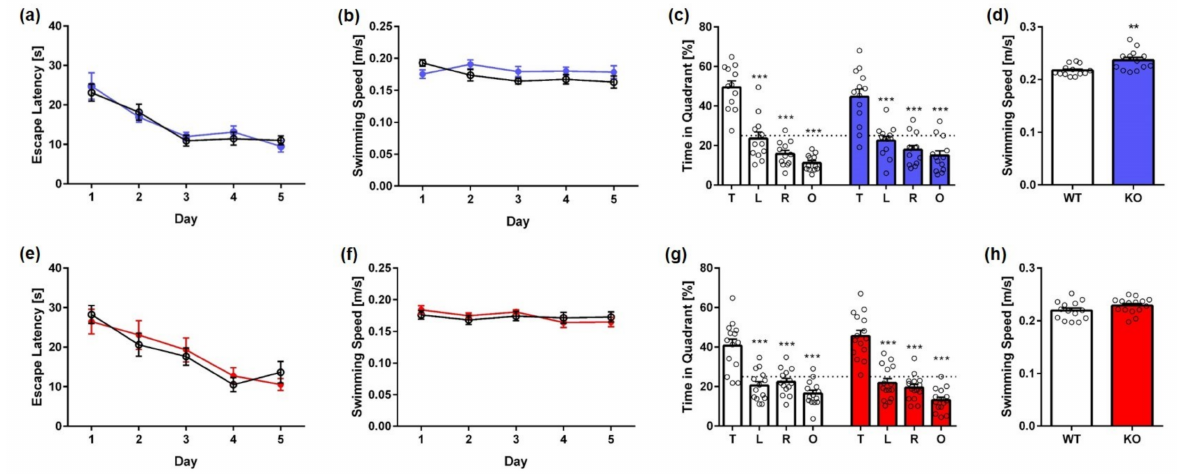
Figure 3. Spatial learning and spatial reference memory of Mover KO mice in the Morris water maze. Spatial learning of KO mice was not altered as mice improved significantly during acquisition training. Escape latencies did not differ significantly between male ( a ) or female KO mice ( e ) and WT animals. Swimming speed did not differ between male ( b ) or female ( f ) KO mice and WT animals in the acquisition training. In the probe trial ( c , d ), all animals displayed a clear preference for the target quadrant. Male KO swam significantly faster than WT animals ( d ). In contrast, swimming speed was not altered in female KO mice ( h ) in the probe trial. Chance level is indicated by a dashed line. Two-way ( a , b e , f ) and one-way ( c , g ) ANOVA followed by Bonferroni multiple comparisons